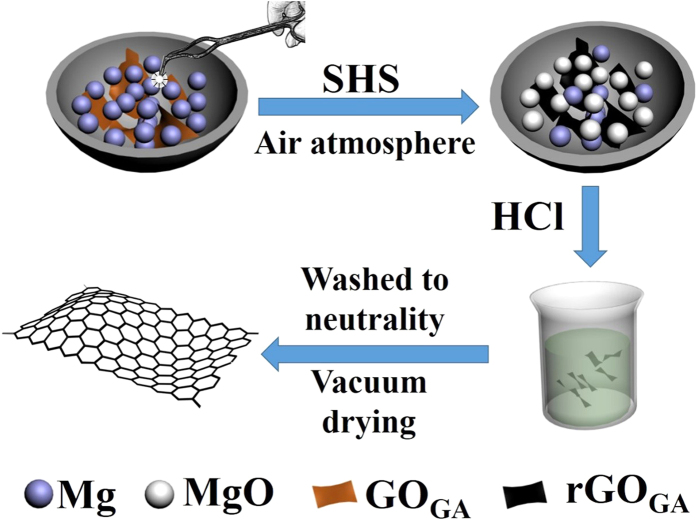
GOGA reduction by Mg in SHS process.